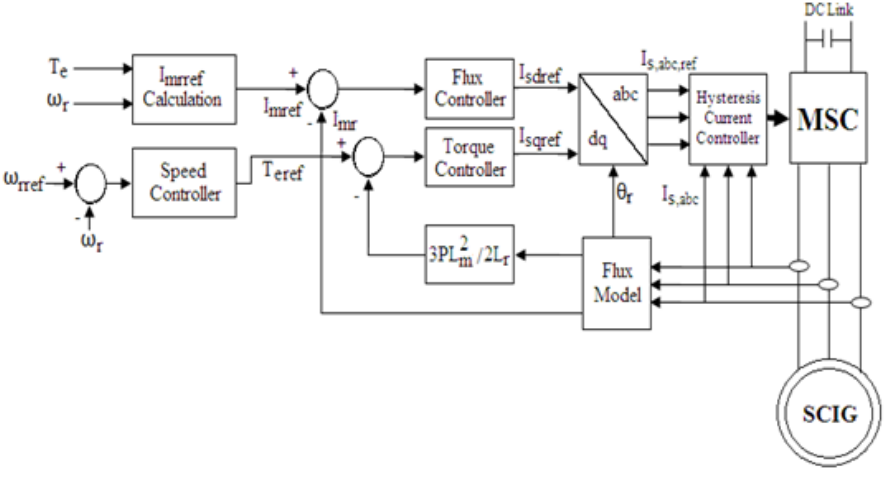
Figure 2. Schematic of the Machine Side Converter control.